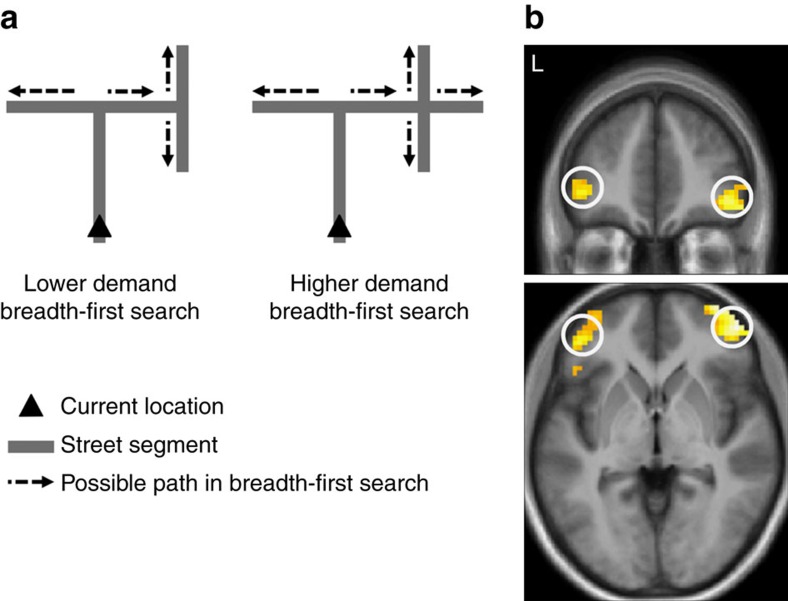
Inferior lateral prefrontal activity correlates with the demands of a breadth-first search at Detours.(a) Diagrams of an example street network contrasting scenarios of lower and higher demand breadth-first search. Breadth-first search assumes the search space (street segments) as a tree and considers all possible solutions within one level before proceeding to the subsequent level. In these diagrams, covering the first layer of the search, the lower demand scenario shows less possible paths, while the higher demand scenario shows a greater number of possible paths. For details see Methods. (b) The statistical parametric map showing correlation (P<0.05 FWE-corrected) of the left and right lateral PFC with planning demands for the first layer of the decision tree (Navigation>Control). We found bilateral lateral PFC activity correlated with planning demands (P<0.001 uncorrected) during Detours in navigation routes, but not in control routes. We found no significant correlations when the planning demands of first and second layer combined were entered in the analysis. The statistical parametric maps are displayed on the mean structural image at a threshold of P<0.005 uncorrected and five voxels minimum cluster size. See Supplementary Table 11 for details of activations. Comparison of parameter estimates of peak voxel in the right lateral PFC showed a significantly greater response at Detours compared with Decision Points (t23=3.49, P=0.002).